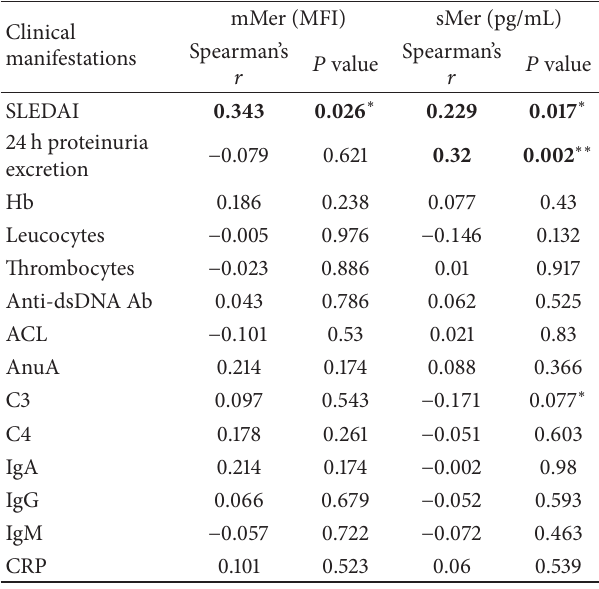
Table 2: Correlations of the mMer on circulating CD14+ mono- cytes/macrophages and sMer in plasma with the studied parameters in patients with